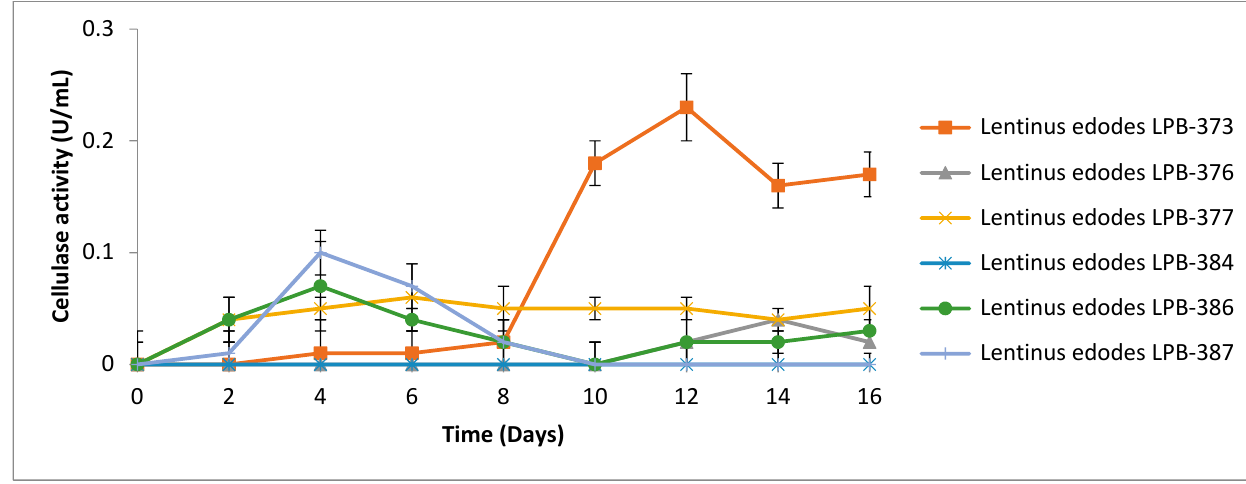
00.10.20.3 Figure 1. Time course of cellulase activity production in liquid culture by Lentinus edodes strains. The error bars represent standard deviations. The averages of results of three independent experiments, each one performed with three biological replicates, are reported. Figure 2. Time course of cellulase activity production in liquid culture by Aspergillus niger strains. The error bars represent standard deviations. The averages of results of three independent experiments, each one performed with three biological replicates, are reported.